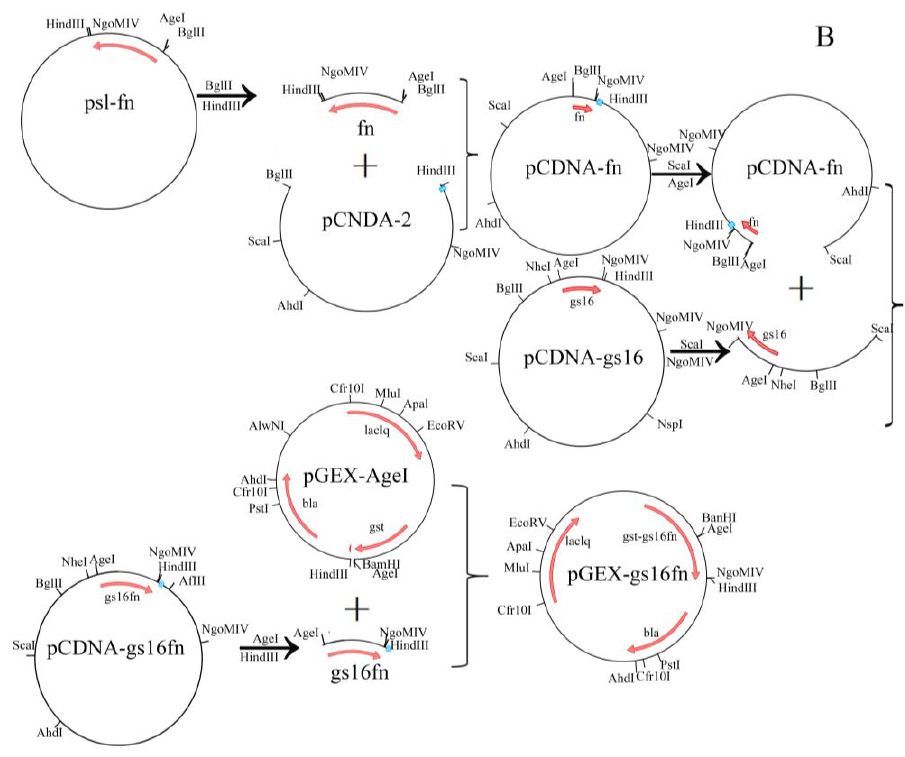
Figure 1. Designed amino acid sequences of the recombinant H-Chain ( A ) and a schematic diagram of the expression vector ( B ).